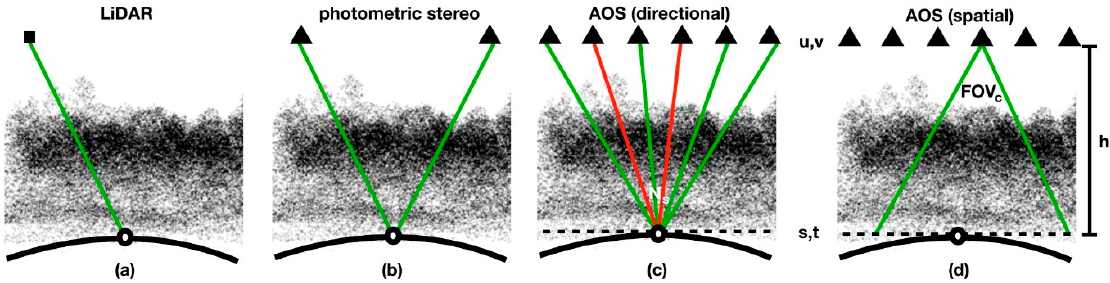
Figure 1. For light detection and ranging (LiDAR) ( a ) a single ray is sufficient to sample the depth of a point on the ground surface, while photometric stereo ( b ) requires a minimum of two views and relies on a dense set of matchable image features. In airborne optical sectioning (AOS), for each point on the synthetic focal plane we directionally integrate many rays over a wide synthetic aperture to support optical sectioning with a low synthetic f-number ( c ). The spatial sampling density at the focal plane depends on the field of view, the resolution of the drone’s camera, and the height of the drone relative to the focal plane ( d ).